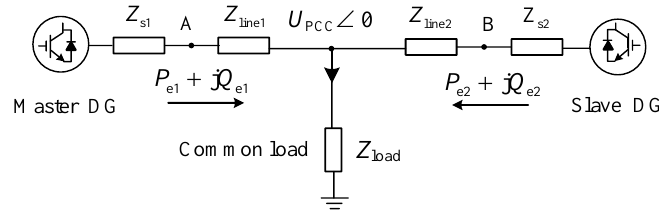
Figure 6. Equivalent schematic diagram of dual-DGs parallel system .